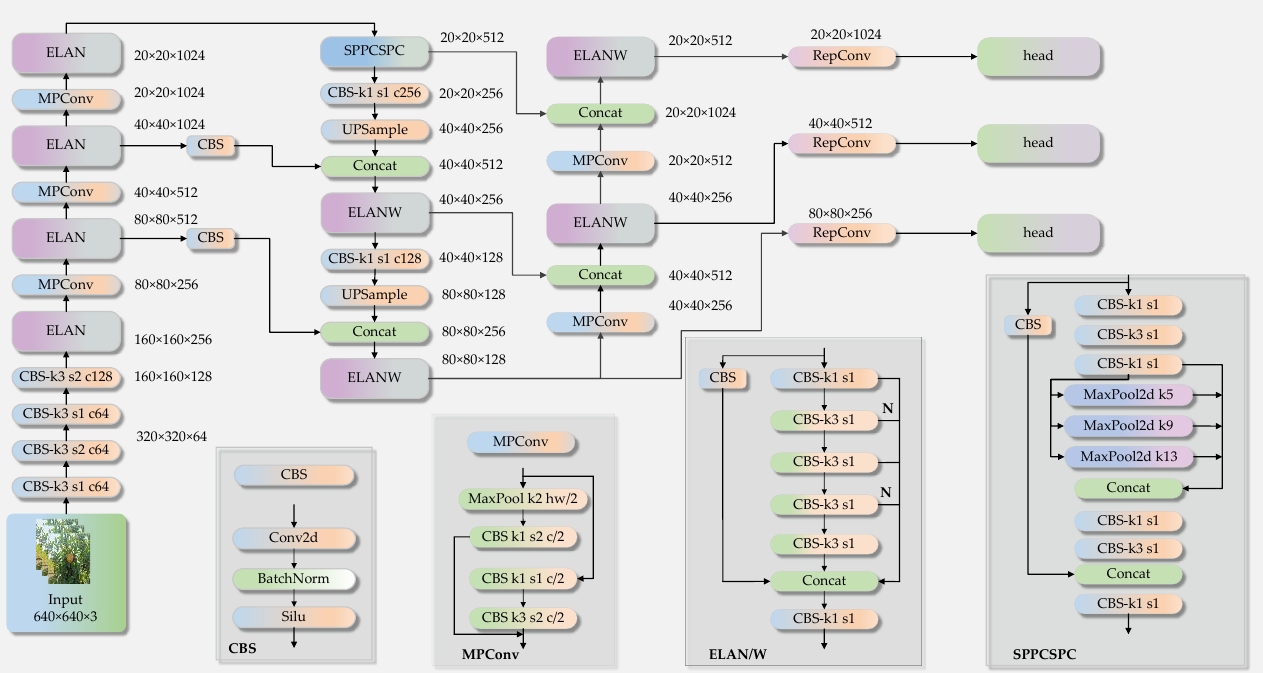
Figure 3. Network structure.